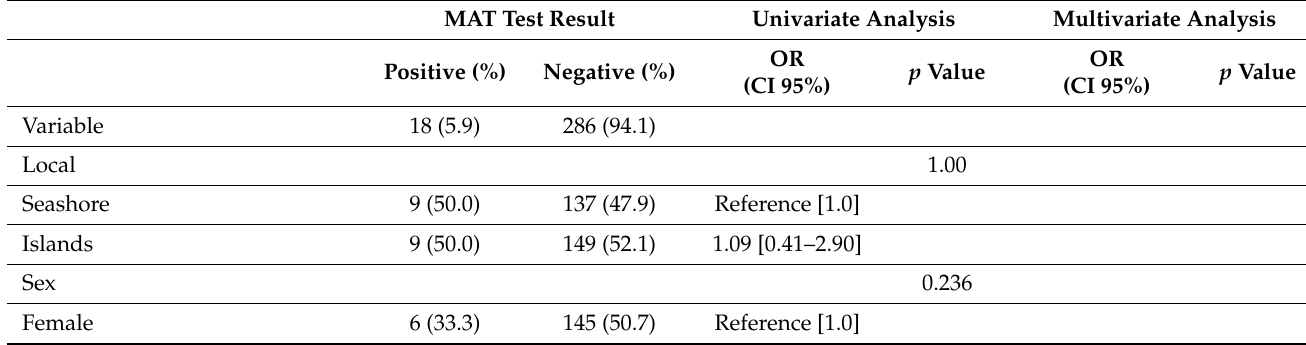
Table 1. Associated risk factors for anti- Leptospira agglutinins in dog population of islands and the seashore mainland of Paran á state, southern Brazil (N = 304), by uni- and multivariate statistical analysis. MAT Test Result Univariate Analysis Multivariate